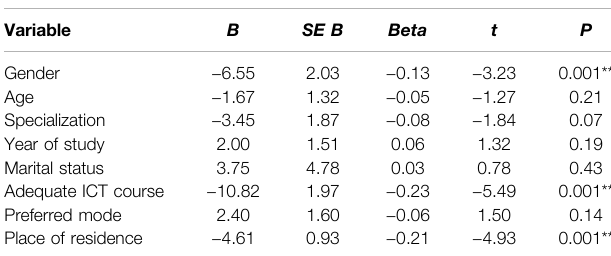
TABLE 2 | Summary of regression for OL